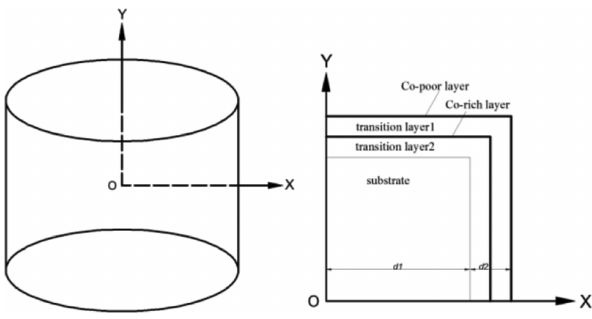
Figure 5: Model of finite element